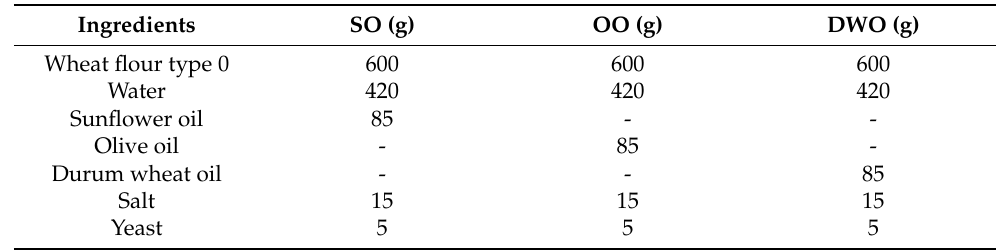
Table 1. Formulation of the experimental focaccia samples. SO = focaccia with sunflower oil; OO = focaccia with olive oil; DWO = focaccia with durum wheat